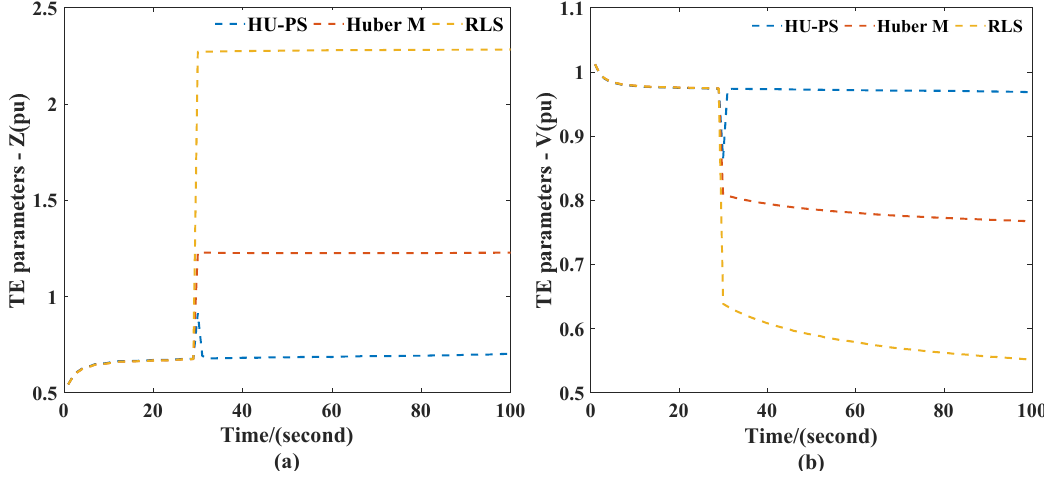
Figure 5. TEPs obtained in case I scenario 2: ( a ) impedance, ( b ) voltage.